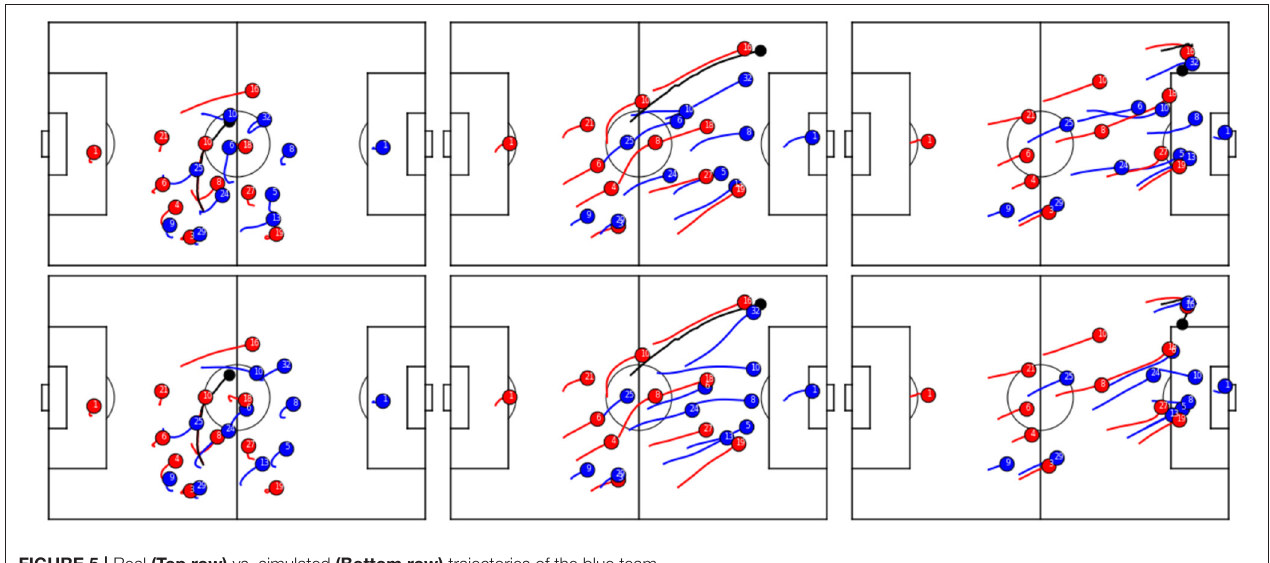
FIGURE 5 | Real (Top row) vs. simulated (Bottom row) trajectories of the blue team.